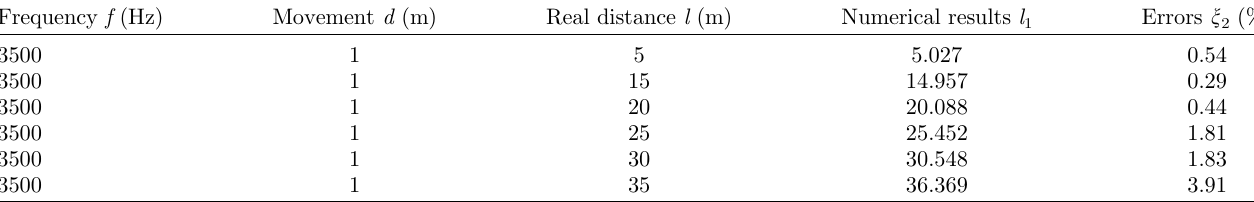
Table 3. Underwater sound localization when the distance l is 5 – 35 m.